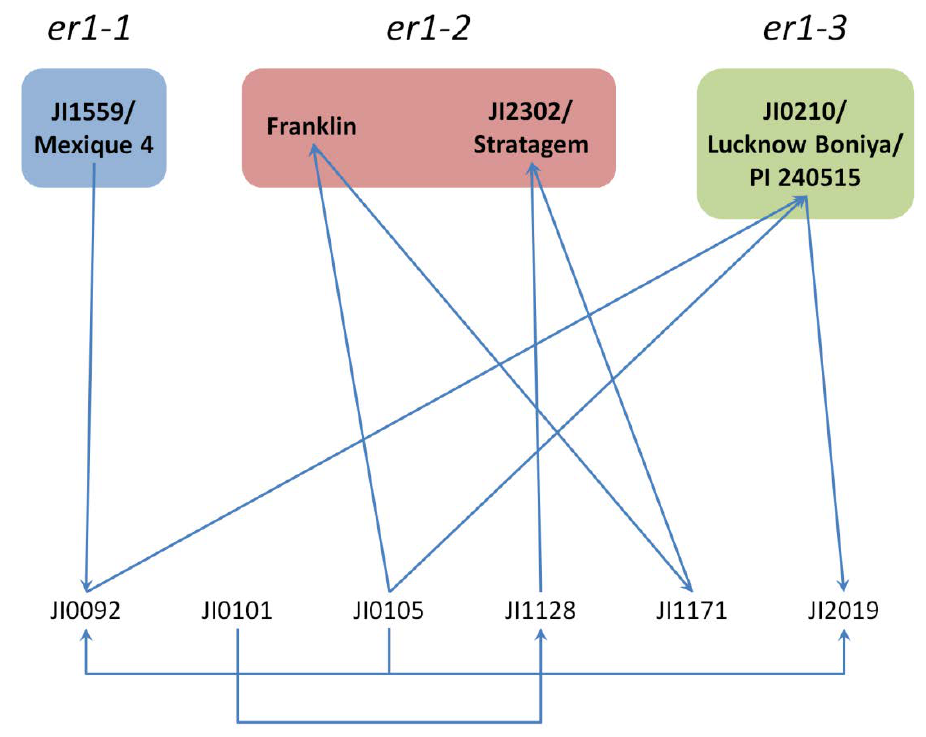
Figure A1. Scheme of the allelism test performed with the pea genotypes from the John Innes Pisum germplasm collection with unknown genetic determinants of resistance to powdery mildew ( bottom row ) and genotypes with previously described resistant MLO1 alleles ( top row ). Arrows indicate directions of crosses.